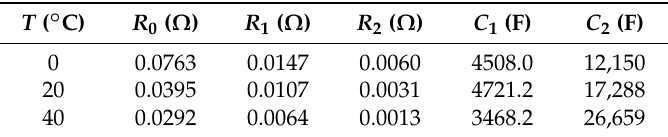
Table 2. Identification of battery model parameters at different